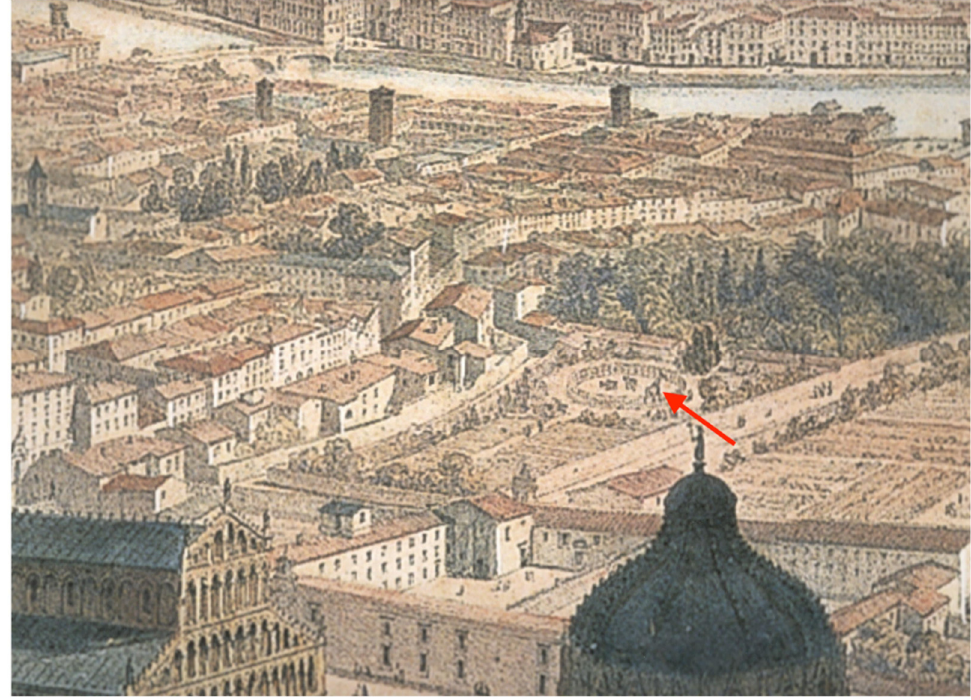
Figure 2. Close-up of Guesdon’s drawing of Pisa, circa 1849. The red arrow points at the giraffe.